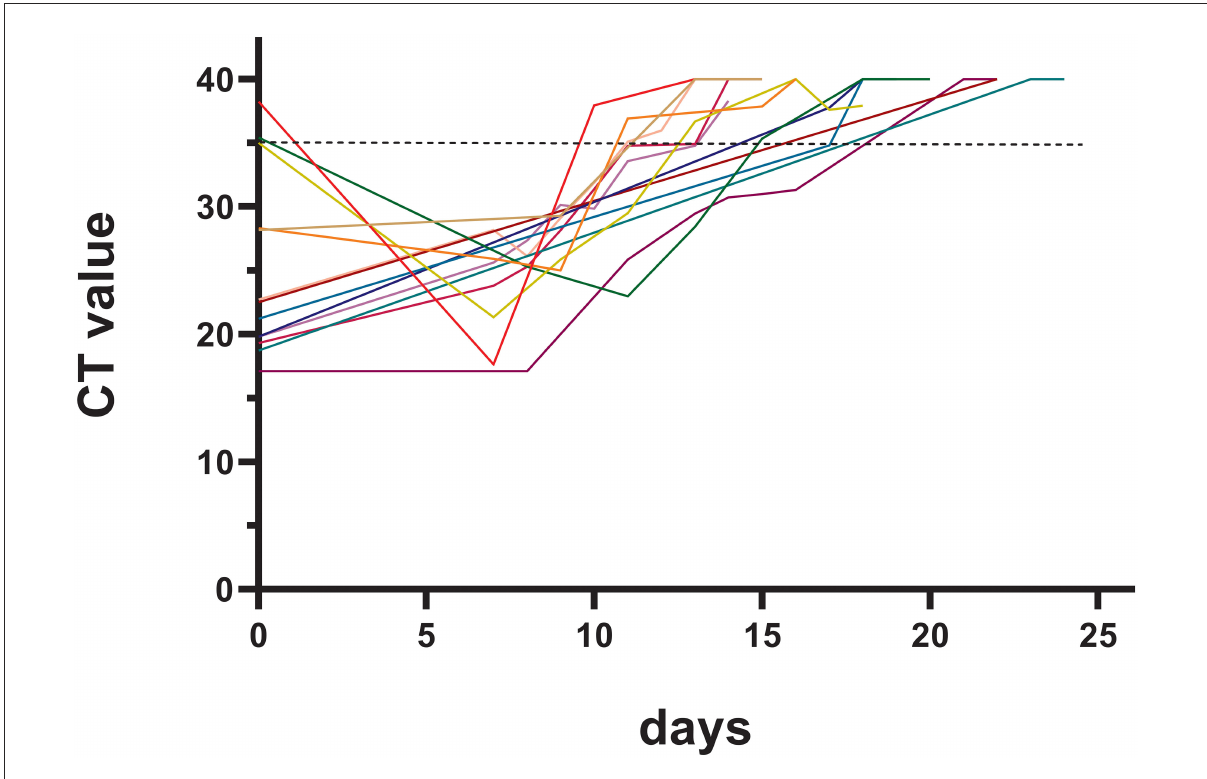
FIGURE1 Changes in the cycle threshold (CT) value of nucleic acid